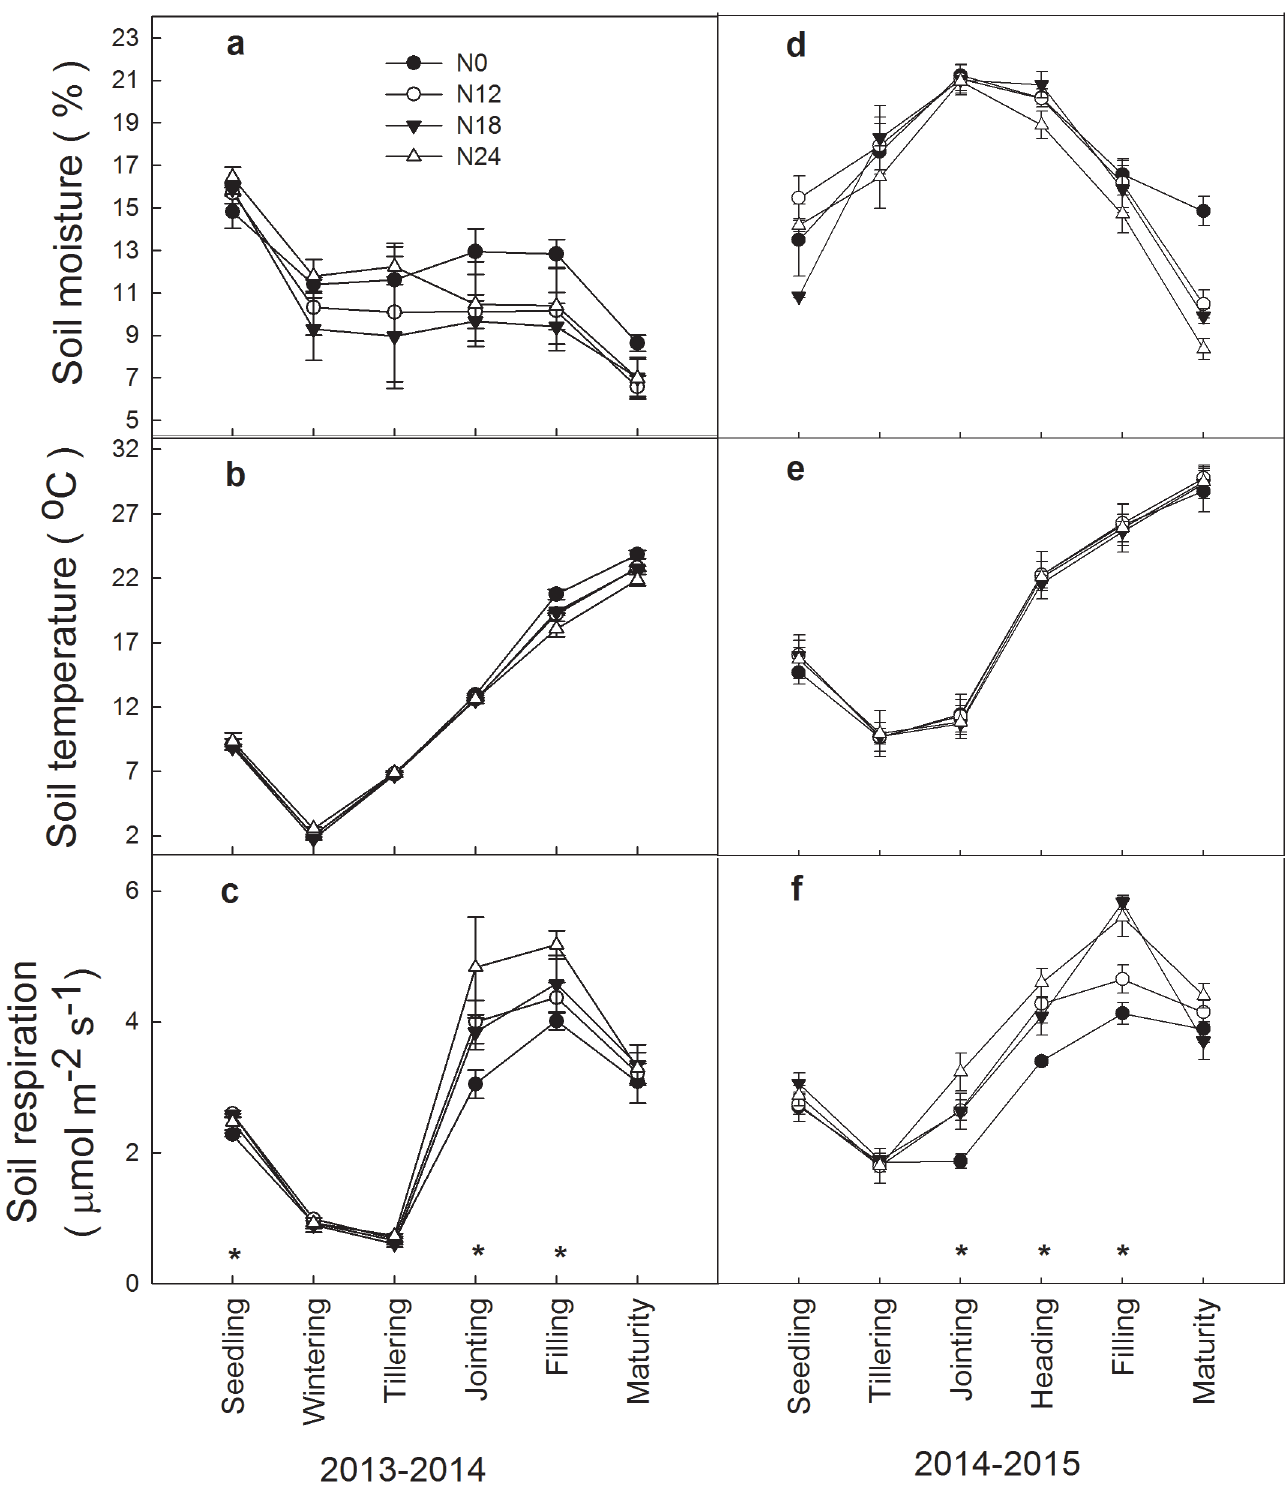
Fig 1. Seasonal dynamics of soil moisture, soil temperature at 10 cm depth, and soil respiration during 2013 – 2014 and 2014 – 2015 winter wheat growing seasons. Asterisks indicate significant differences between soil respiration under N0 and N24 at P < 0.05.